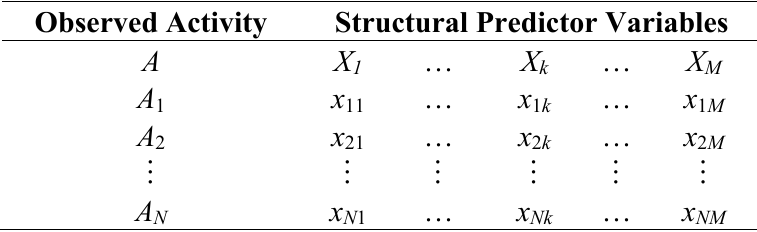
Table 1. The QSAR working table for Equation (1) in the presence of M-structural descriptors for N -compounds with known